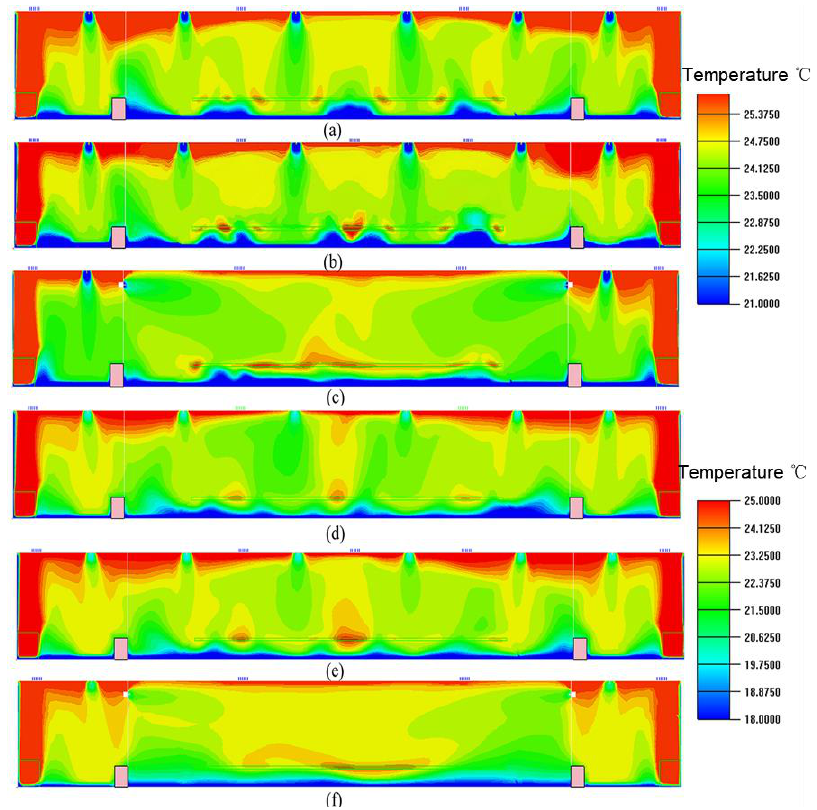
Figure 11. Temperature distribution at Z = 18 m: Scheme 1 in summer ( a ), and in winter ( d ); Scheme 2 in summer ( b ), and in winter ( e ); Scheme 3 in summer ( c ), and in winter ( f ). (2) Scheme 2: Horizontal Exhaust.